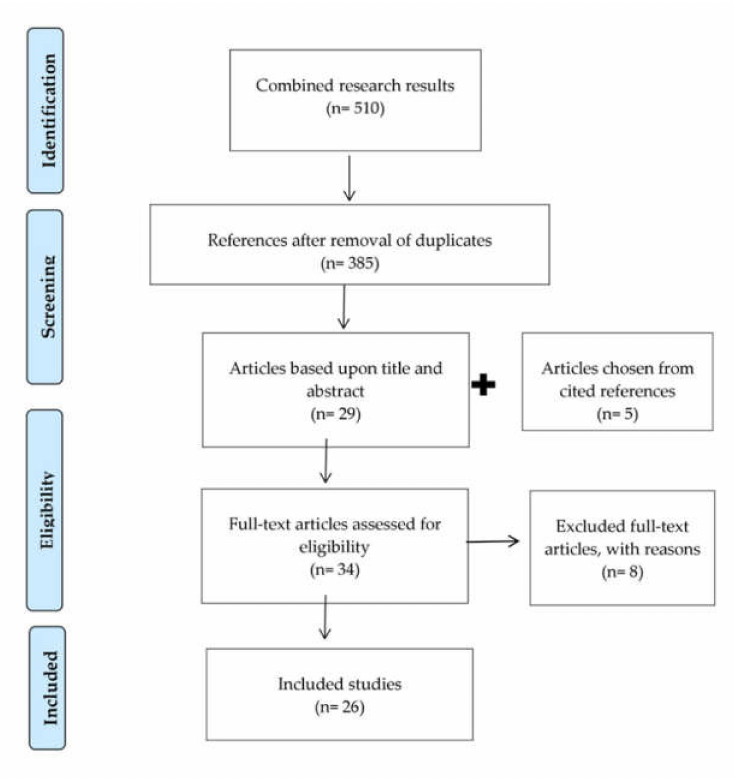
Figure 1. Preferred Reporting Item for Systematic Reviews and Meta-Analyses (PRISMA)